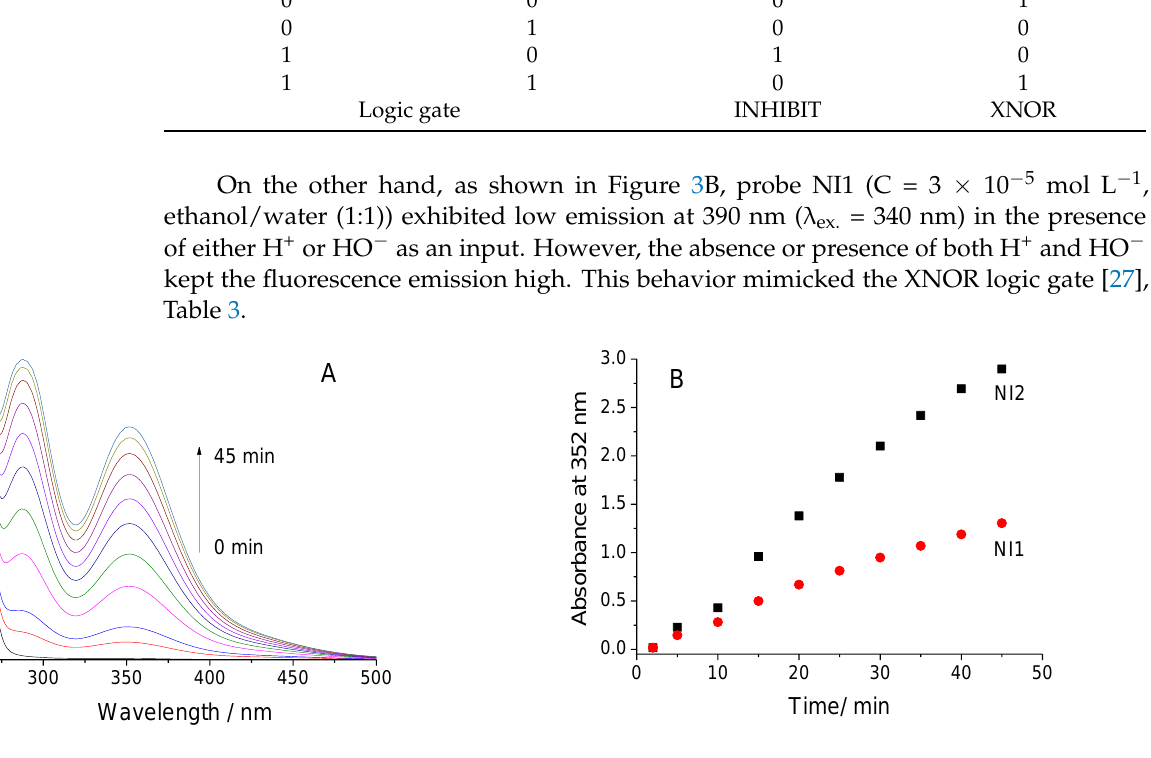
Figure 3. Absorption spectra of KI in the presence of NI2 plotted as a function of irradiation time ( A ); dependence of absorbance at 352 nm, corresponding to I 3- caused by NI1 and NI2 ( B ).